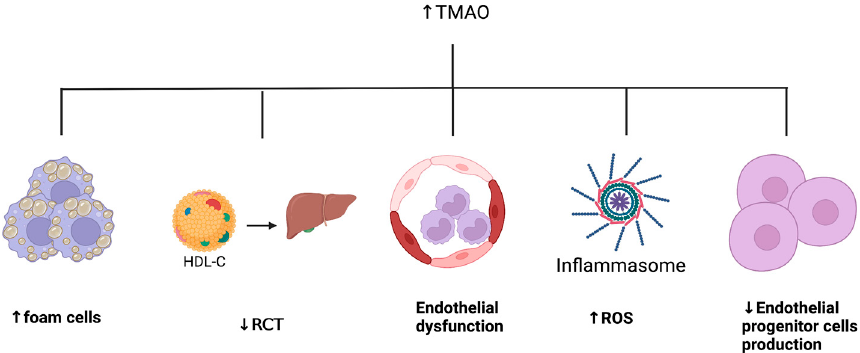
Figure 2. Proposed mechanisms linking trimethylamine N-oxide to atherosclerotic cardiovascular disease. HDL-C: high-density lipoprotein-cholesterol, RCT: reverse cholesterol transport, ROS: reactive oxygen species, TMAO: trimethylamine N-oxide.